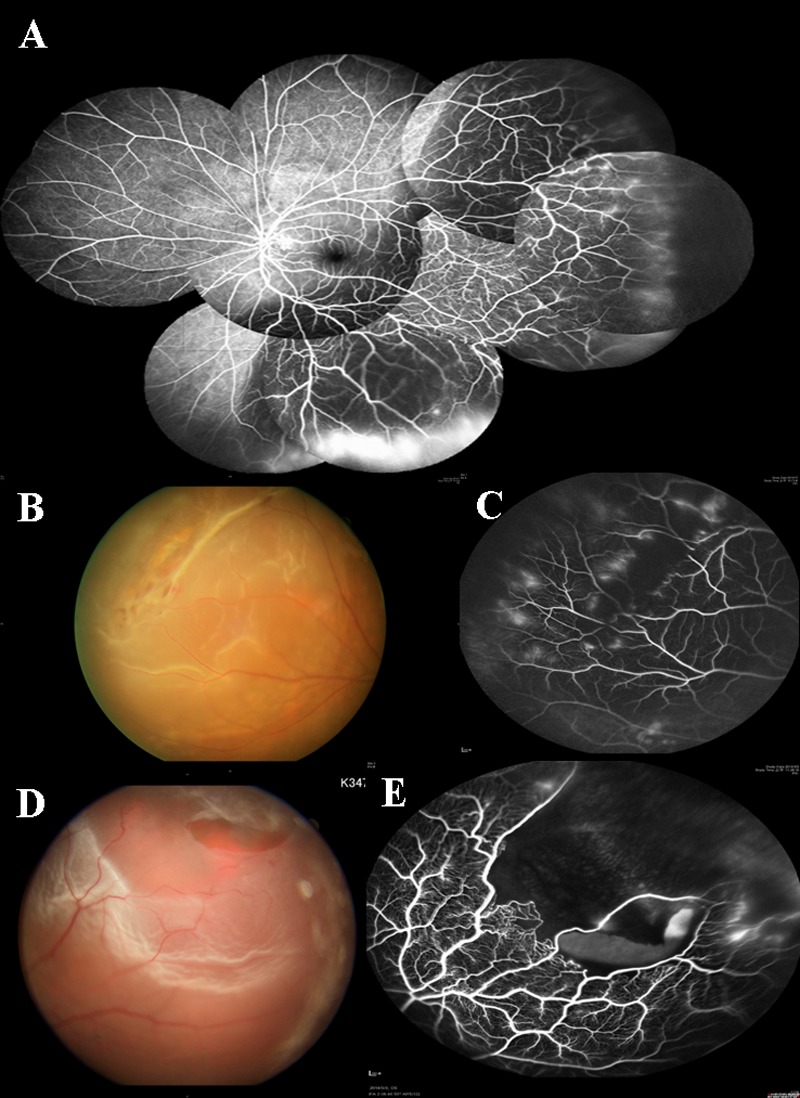
Color and FA pictures of group 1 eyes.(A) FA of an eye with group 1 retinal vasculature. Note there is a dichomatous ramified pattern of peripheral retinal vasculature with gradual tapering. Marked leakage is noted in the detached, peripheral retina. Area of peripheral retinal avascularity was noted, which was within 1mm in width. (B) Fundus photo of a lattice degeneration within the vascular zone in an eye with type 1 vascular pattern. (C) Fluorescein angiography of the lattice degeneration showing large vessels crossing over the lattice degeneration, with loss of the small vasculature within the area of lattice degeneration. Telangiectasia was noted at the peripheral retinal vasculature outside the area of lattice degeneration with normal dichomatous vascular pattern. Vascular leakage was noted at some parts of peripheral retinal vasculature and around the lattice degeneration. (D) Fundus photo of a lattice degeneration associated tear at the margin of vascular zone with type 1 vascular pattern. (E) Fluorescein angiography showing loss of small vasculature within the lattice degeneration and lack of vasculature peripheral to the lattice degeneration. Vascular anastomosis at inner margin of lattice degeneration and telangiectatic vessels within detached retina were also noted.